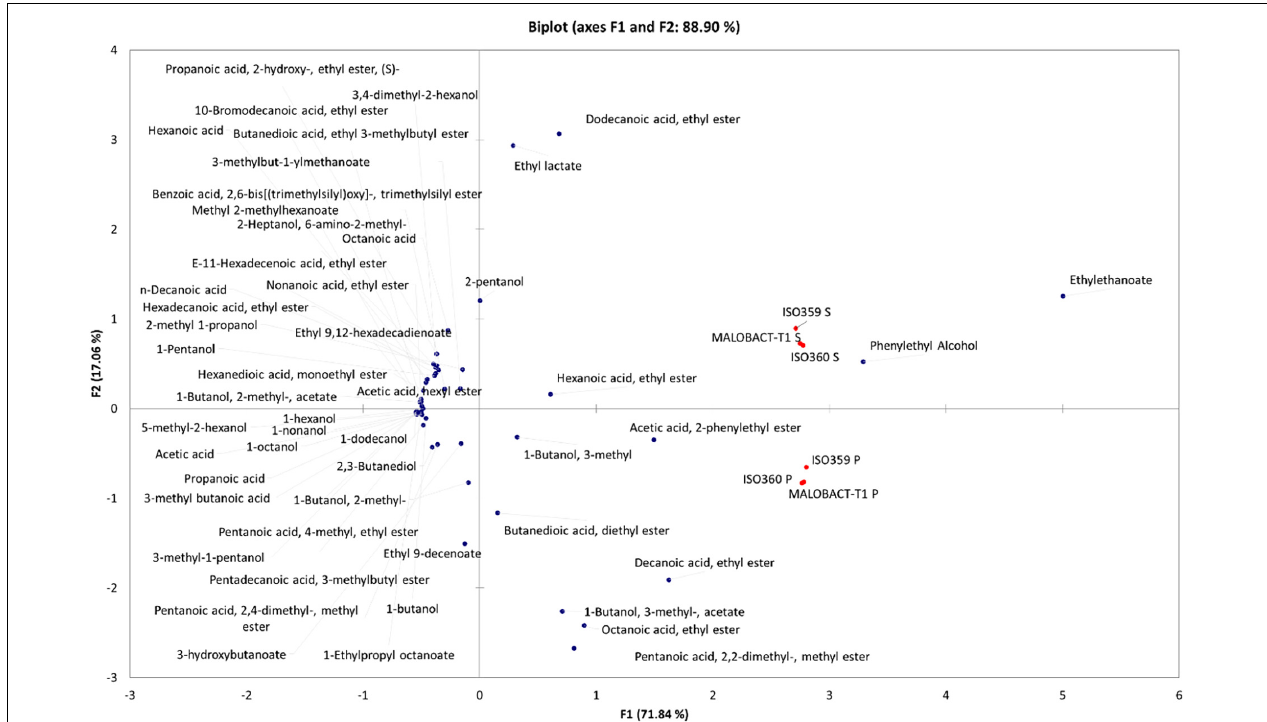
FIGURE 4 | Principal component analysis (PCA) encompassing aroma compounds released in wines by planktonic and biofilm-detached cells of O. oeni. The biplot (score and loading) of the first two principal components showed 88.9% of the cumulative